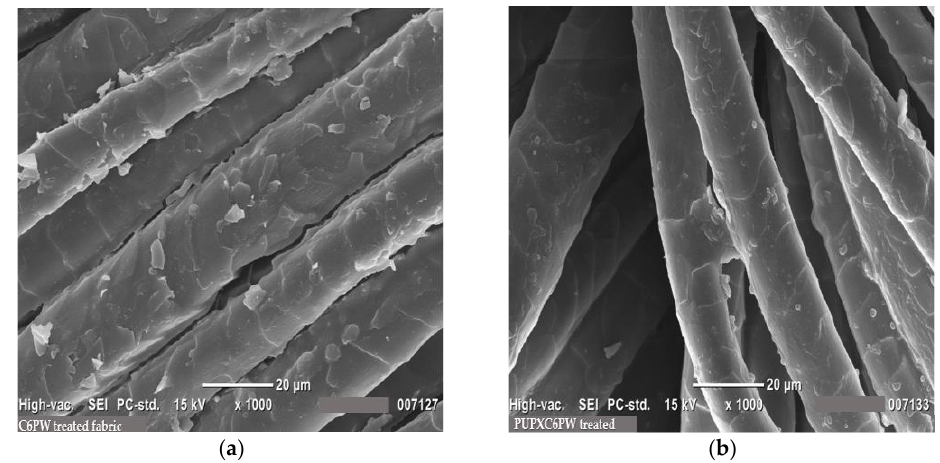
Figure 7. SEM images of the fabric treated with C6PW ( a ) and combination PUPXC6PW ( b ). Table 3. Spray test results with 100% water and (90/10) (water/isopropyl alcohol).